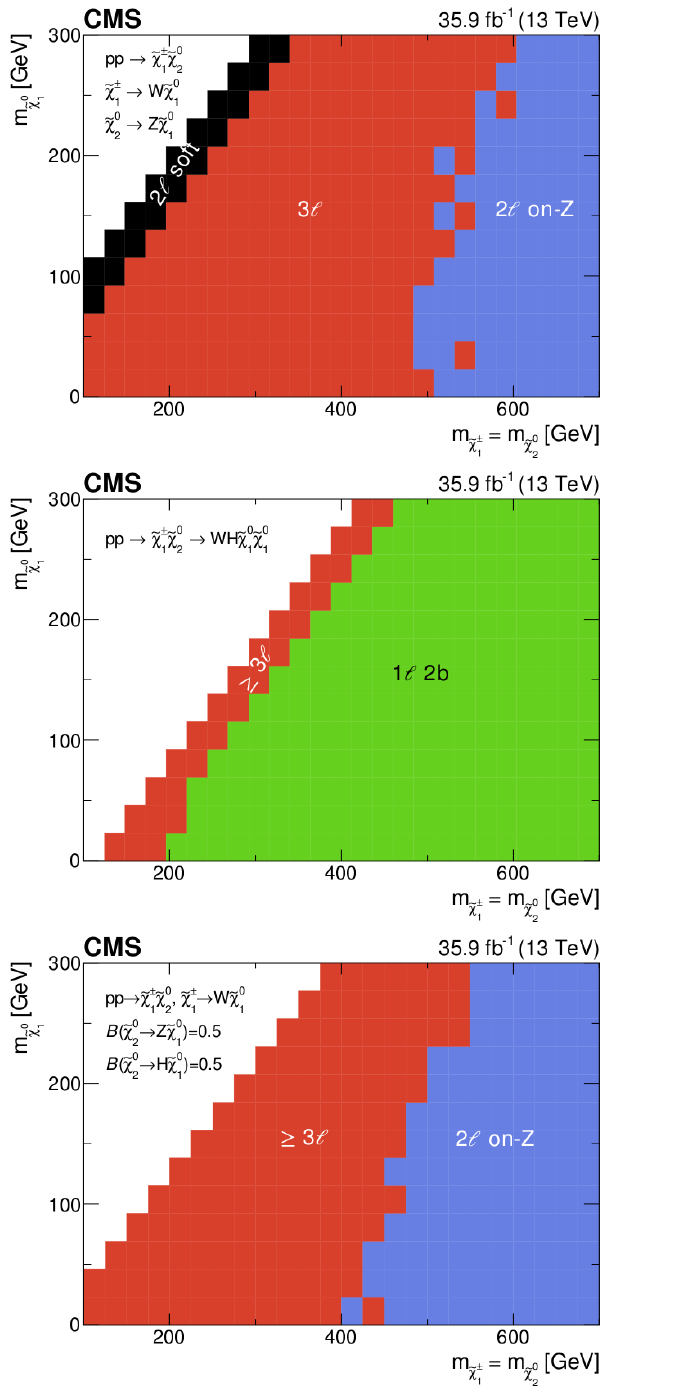
Figure 9 . The analysis with the best expected exclusion limit at each point in the plane of m and m for the models of (cid:31) (cid:6) (cid:31) 0 production with (upper) the WZ topology, (middle) the WH 2 1 e (cid:31) 0 1 topology, and (lower) the mixed topology 50% branching fraction to each of WZ and WH. e e